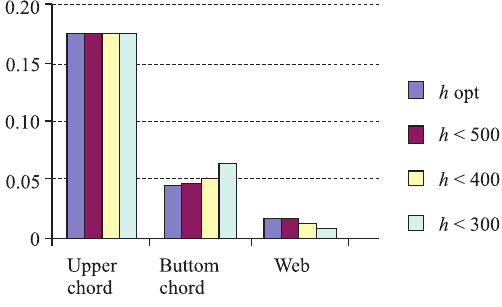
Fig. 12. Steel expenditures in m 3 for chords and webs with reference to both load cases